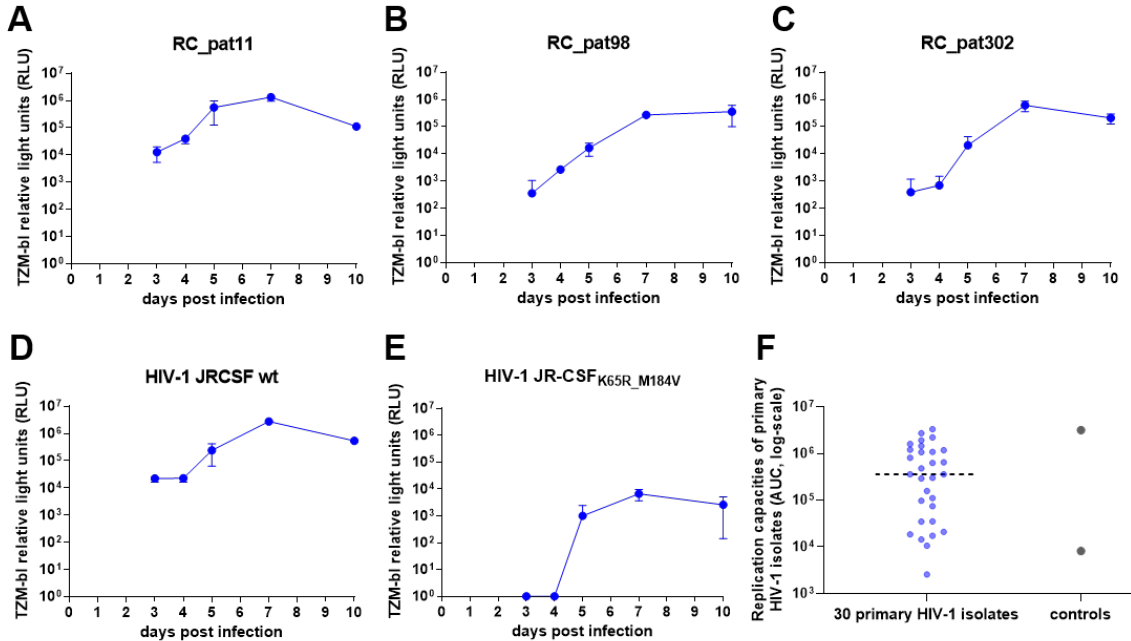
Figure 3. Pilot experiment of the optimized high throughput parallel infection assay using 30 primary HIV-1 isolates. ( A – E ) These graphs depict the replication kinetics from three primary HIV-1 isolates ( A – C ) and the two control viruses ( D , E ). The x-axes represent the days post infection, and the y-axes display the TZM-bl luciferase expression measured by relative light units (RLU) in log-scale. ( F ) The jitter plot depicts the distribution of the replication capacities for the 30 primary HIV-1 isolates and the control viruses. The x-axis depicts the samples, and the y-axis depicts the replication capacities (AUC values) in log-scale. The dotted horizontal line represents the median.